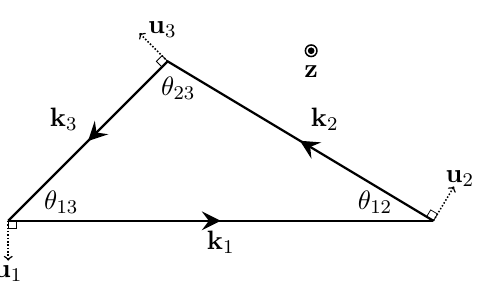
Figure 10 . Diagram defining the vectors which make up the polarization tensors in